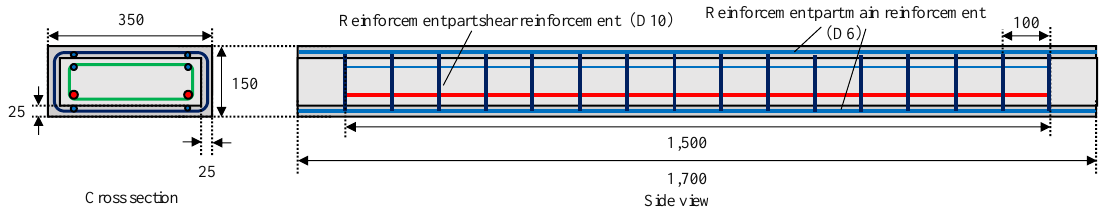
Figure 5. Dimensions of the RPCM reinforced specimen.